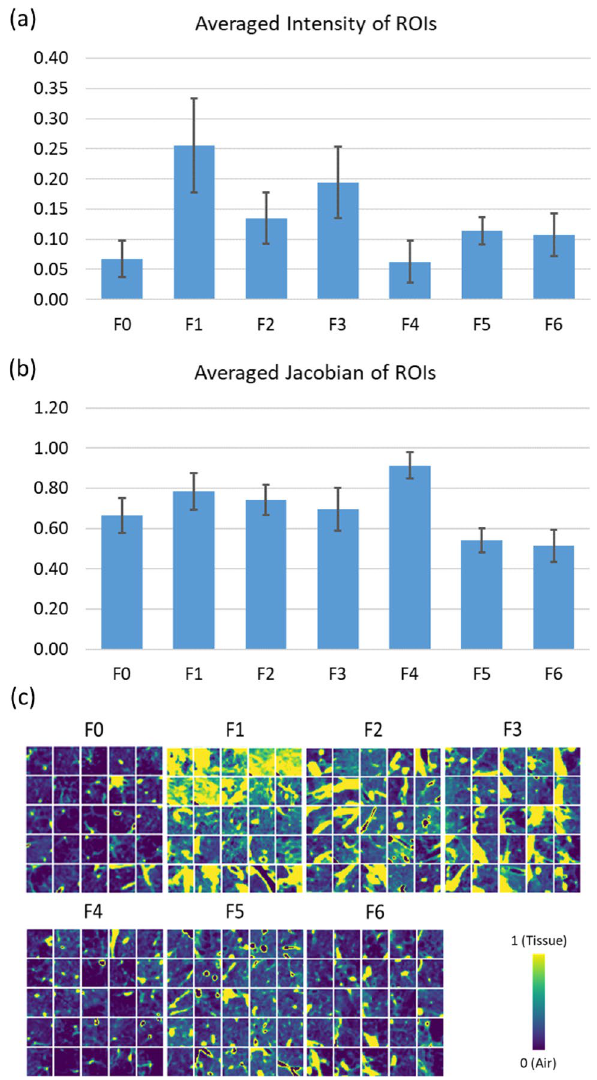
Figure 2. Bar charts showing ( a ) the averaged intensity of ROIs with large contribution to each factor and ( b ) the averaged Jacobian of ROIs with large contribution to each factor. Significant differences (p < 0.001) between factors were found in both the averaged intensity and the averaged Jacobian by Welch’s ANOVA. The pairwise Games–Howell post-hoc tests showed that all the pairs were significantly different except for the pair of F5 and F6 that was not significantly different for either the averaged intensity (p = 0.718) or the averaged Jacobian (p = 0.118). ( c ) Samples of the ROIs taken from the pattern-clusters with strong contribution to each